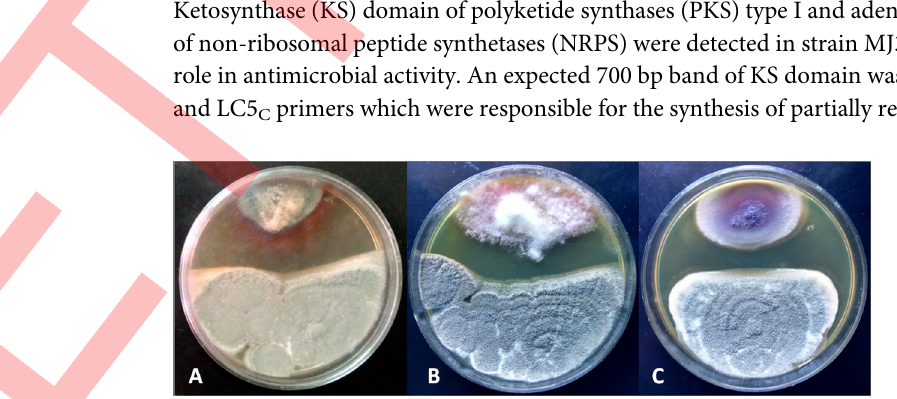
Fig 4. Endophyte- pathogen interactions observed in dual culture antagonism bioassay of strain MJ31 against A: F . graminearum , B: F . culmorum and C: F . oxysporum f. sp. pisi